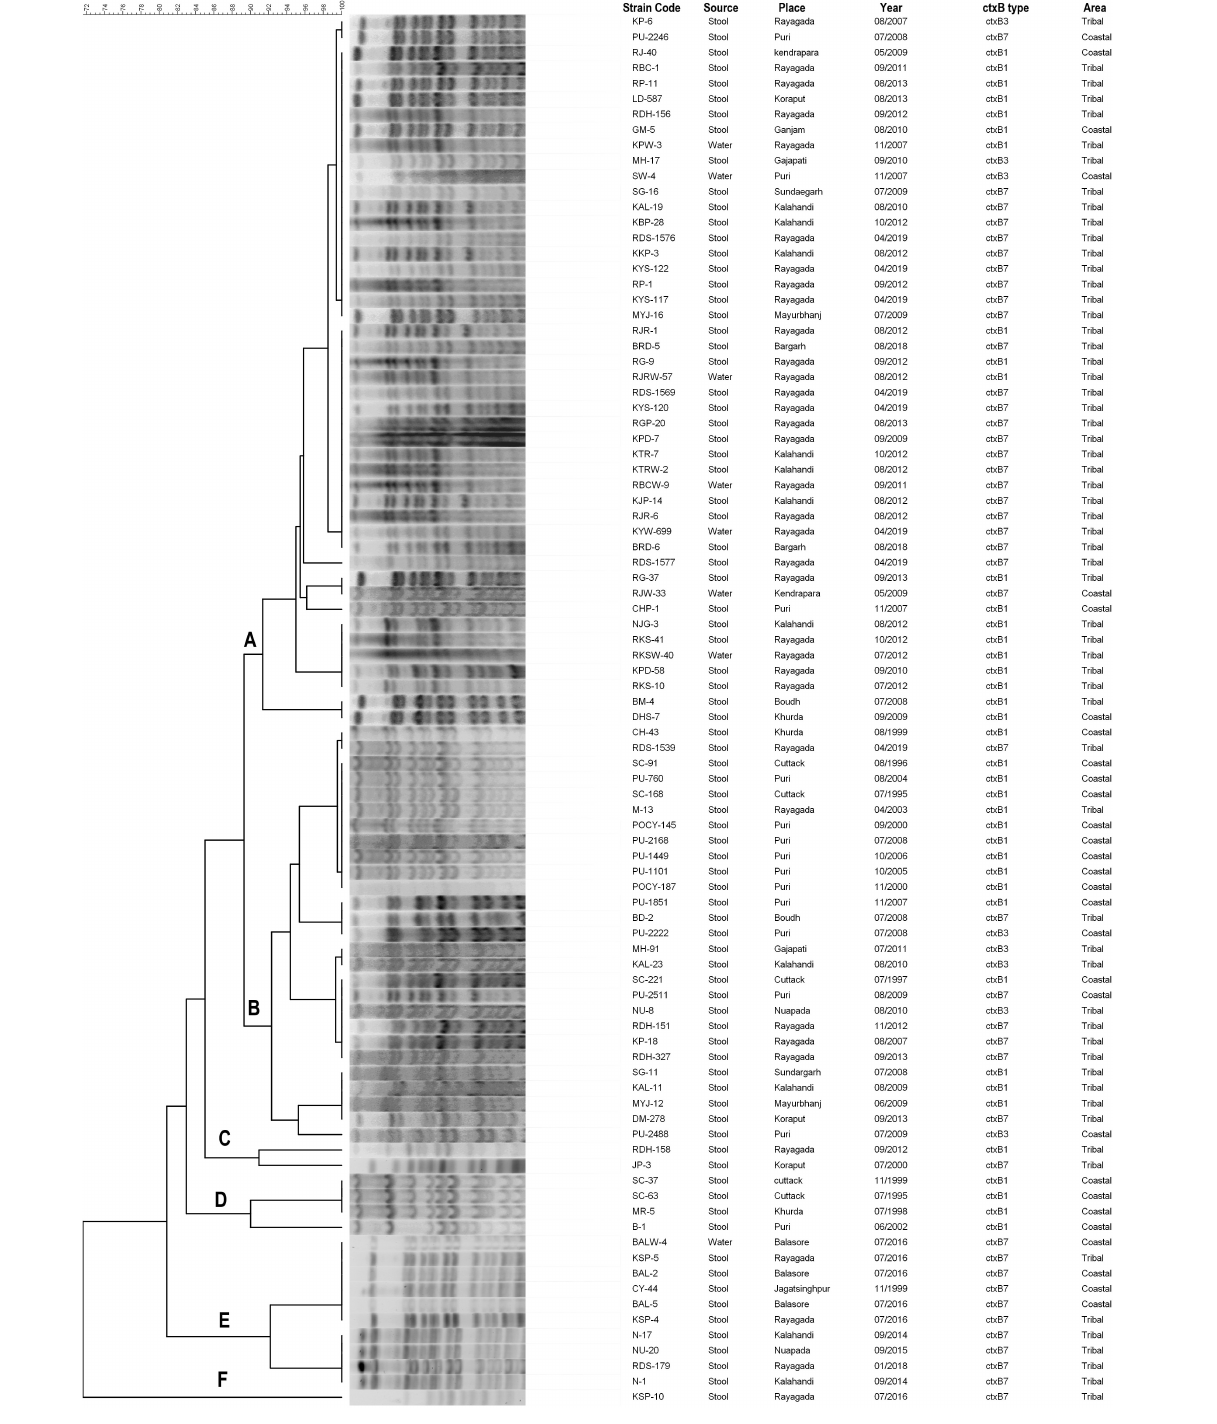
of infection in the tribal areas. So, as the people in the tribal areas depend on the stream, nala, chua, and river water, the stored water in the hilltops supplied to the villages should be chlorinated